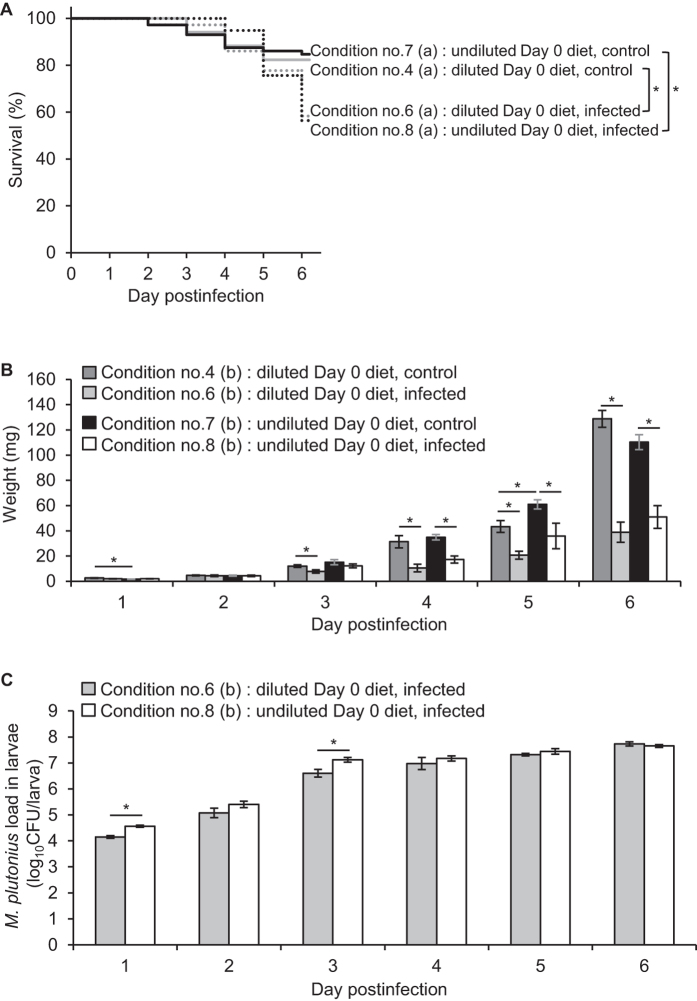
The influence of dilution of the Day 0 diet on the survival and growth of larvae (experimental condition nos 4 and 6–8).(A) Survival of control and infected larvae. Larvae in infected groups (nos 6 and 8) were fed with 10-μl Day 0 diet containing M. plutonius DAT606(CC3) at a final concentration of 1.3–2.1 × 107 CFU/ml (Supplementary Table S1). Survival rates at day 6 pi were 82.4% (no. 4), 58.3% (no. 6), 84.7% (no. 7) and 56.4% (no. 8). Asterisks indicate a significant difference in the survival rate at day 6 pi (Fisher’s exact test, P < 0.05). (B) Larval weight presented as mg (mean ± SEM). Larvae in infected groups (nos 6 and 8) were fed with 10-μl Day 0 diet containing M. plutonius DAT606(CC3) at a final concentration of 1.3–1.8 × 107 CFU/ml (Supplementary Table S1). Five larvae were randomly selected from each group daily and weighed. The larvae were also used for determination of bacterial loads in larvae. Statistical differences were analysed between two control groups (nos 4 and 7), two infected groups (nos 6 and 8) and control and infected groups (between nos 4 and 6 and between nos 7 and 8). Asterisks indicate a significant difference (two-tailed Student t-test, P < 0.05). (C) Bacterial loads in infected larvae calculated by real-time PCR and presented as log10CFU/larva (mean ± SEM). Asterisks indicate a significant difference (two-tailed Student t-test, P < 0.05). Total no. of larvae used for each experiment is shown in Supplementary Table S1.